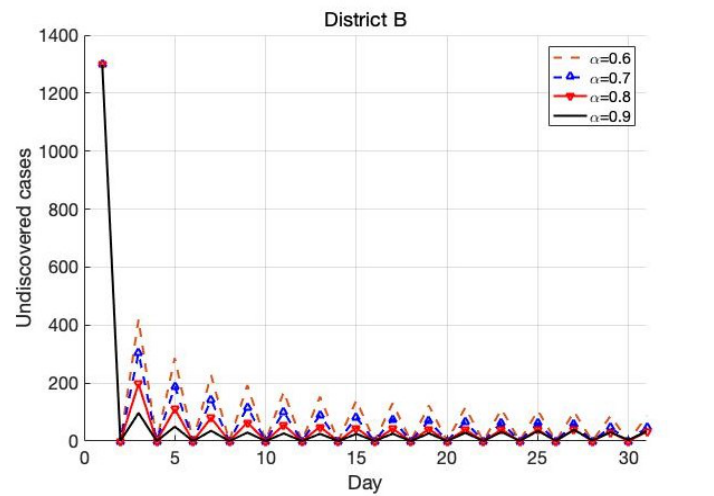
Figure 11. Model results for undiscovered cases.